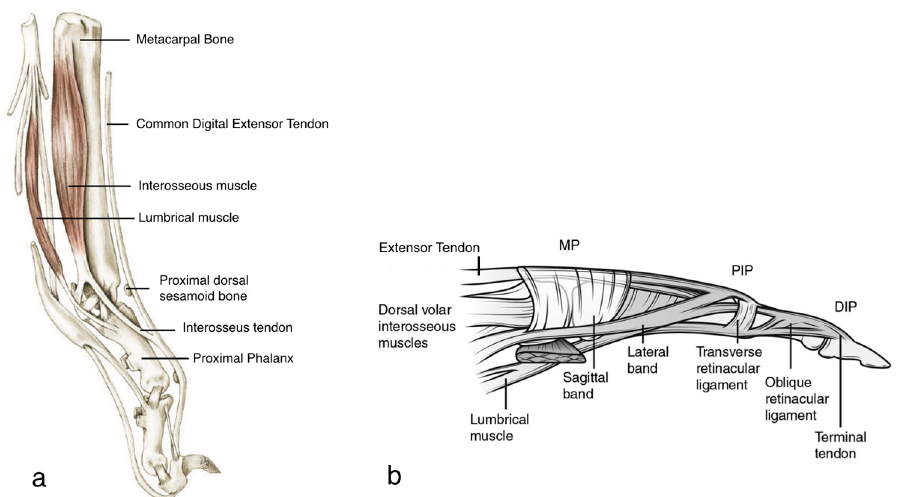
Figure 4. Anatomical comparison between the digits of dog and humans. ( a ) Anatomy of the dogs, medial view. The extensor mechanism at the MCP joint with the interosseus tendon gliding on the dorso-medial aspect of the first phalanx is represented. ( b ) Extensor mechanism at the MCP joint in humans, radial view. The sagittal band arises from the volar plate and intermetacarpal ligament and stabilizes the extensor tendon. DIP: distal interphalangeal joint; MP: metacarpophalangeal joint; PIP: proximal interphalangeal joint. Note the correspondence between the interosseus tendon of dogs and the lateral band of humans.